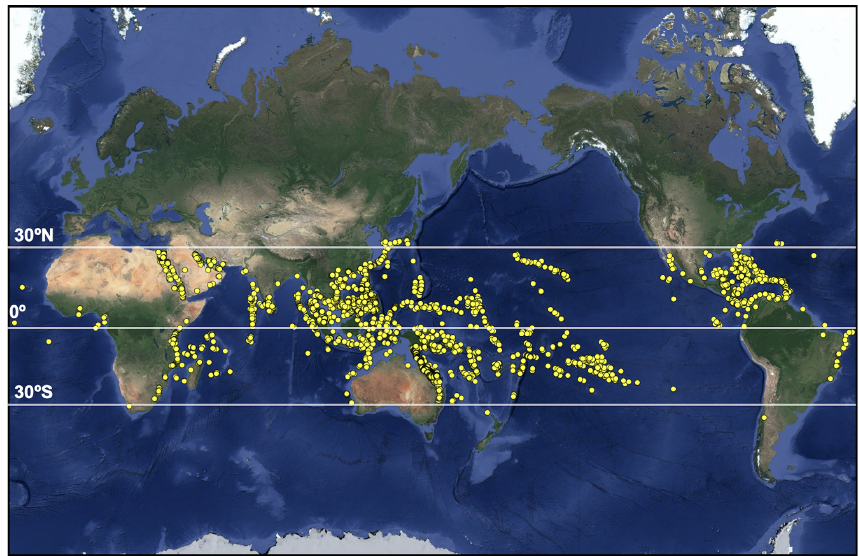
Figure 1. Global distribution of tropical coral reefs (map data © 2019 Google). Locations provided by ReefBase (http://www.reefbase.org, last access: 16 July 2018).